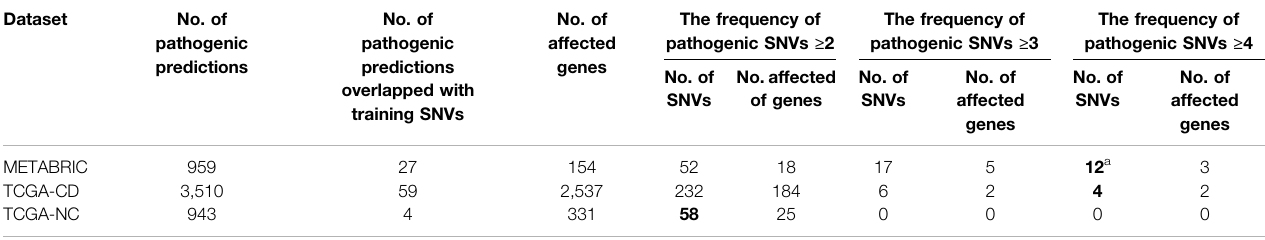
TABLE2| NumberofpathogenicSNVs.TheywerepredictedbytheSVMmodelsfortheSNVsfrompredictiondatasetsregardingtheoptimumcut-offs[0.55forMETABRIC and TCGA-coding (TCGA-CD), and 0.41 for TCGA-noncoding (TCGA-NC)]. Dataset